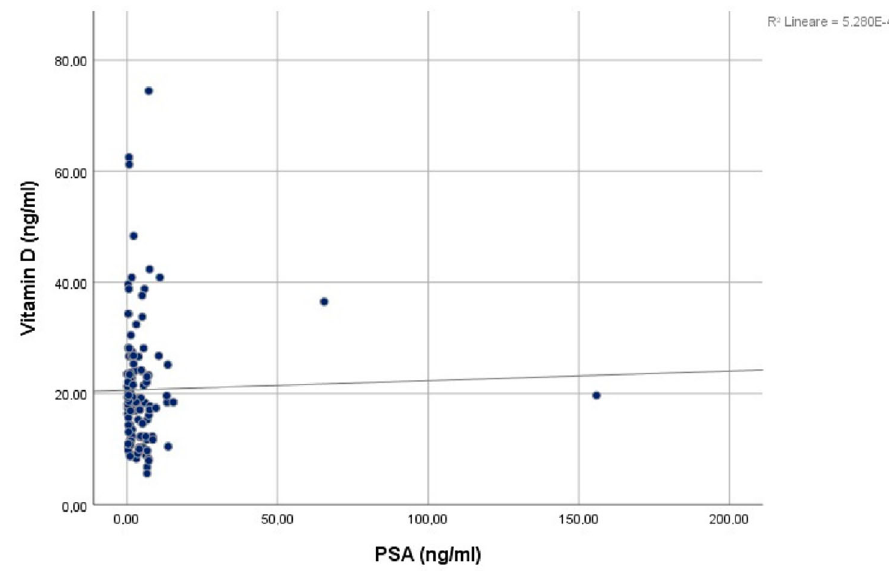
Figure 2. Graphical result of the Spearman’s rank correlation test.